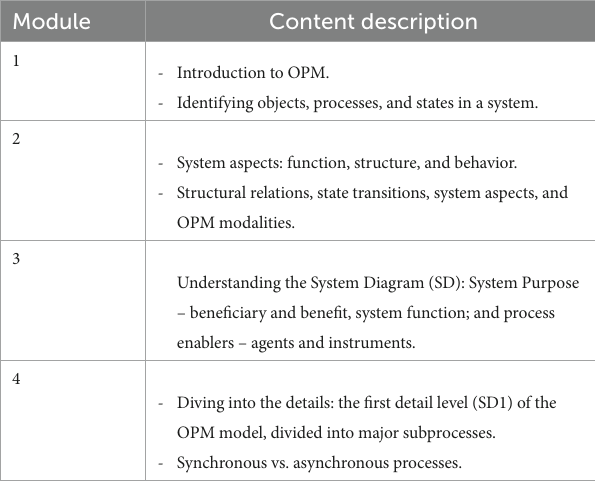
TABLE 3 The content of the four modules that formed the learning